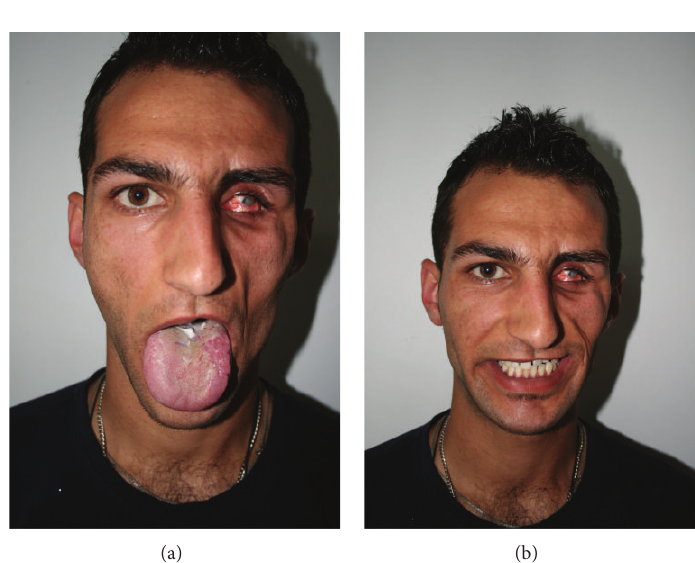
Figure4:(a)Atrophyandfissuringofthelefthemiglossus.(b)Maxillaryatrophyhasdisplacedtheleftupperteethinanupwardandbackward